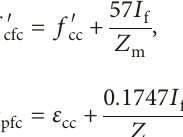
Figure 5: Failure modes of all specimens after completion of the tests: (a) specimen C (d) specimen C F3